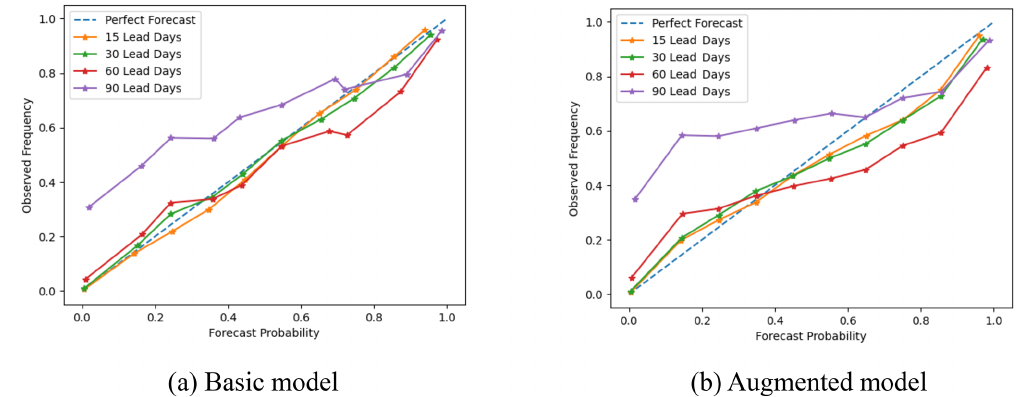
Figure 6. Calibration curves for the Basic and Augmented model for sea ice presence forecasts initiated from 1 to 30 September for different lead days. At 90 lead days, both models underestimate the probability of sea ice when observed frequencies are less than 0.75 and overestimate the probability of sea ice at higher probabilities. The Basic model is well-calibrated for short lead